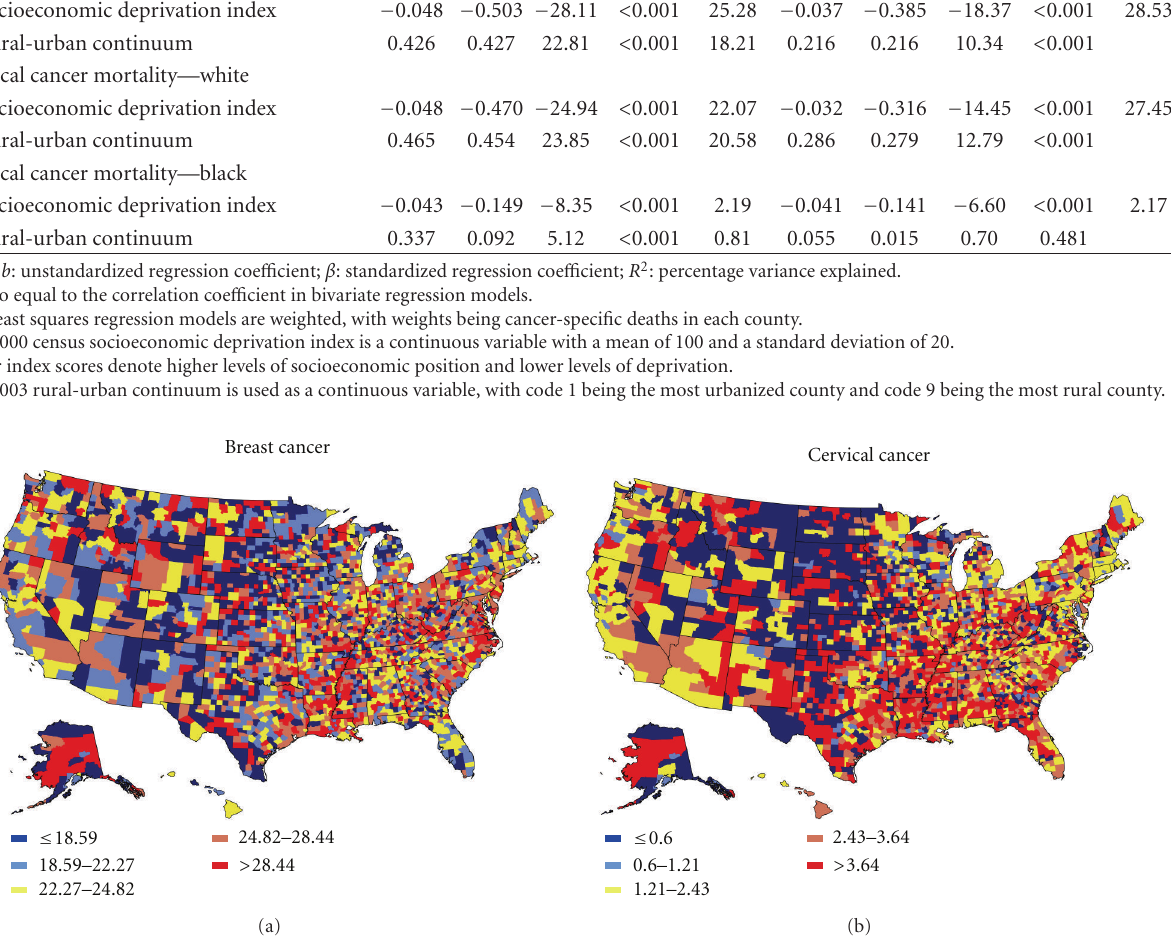
Figure 5: Breast and cervical cancer mortality rates per 100,000 population (age adjusted to the 2000 population), United States, 2003–2007 (3,141